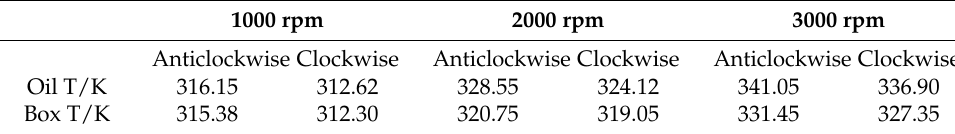
Table 3. Comparison of the gear steering temperature appreciation.